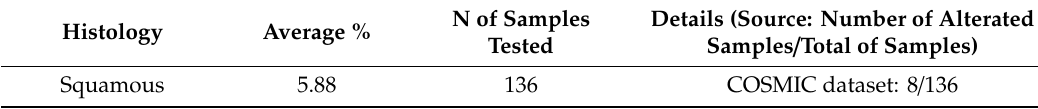
Table 4. Incidence of PTEN alterations in vulvar cancer according to